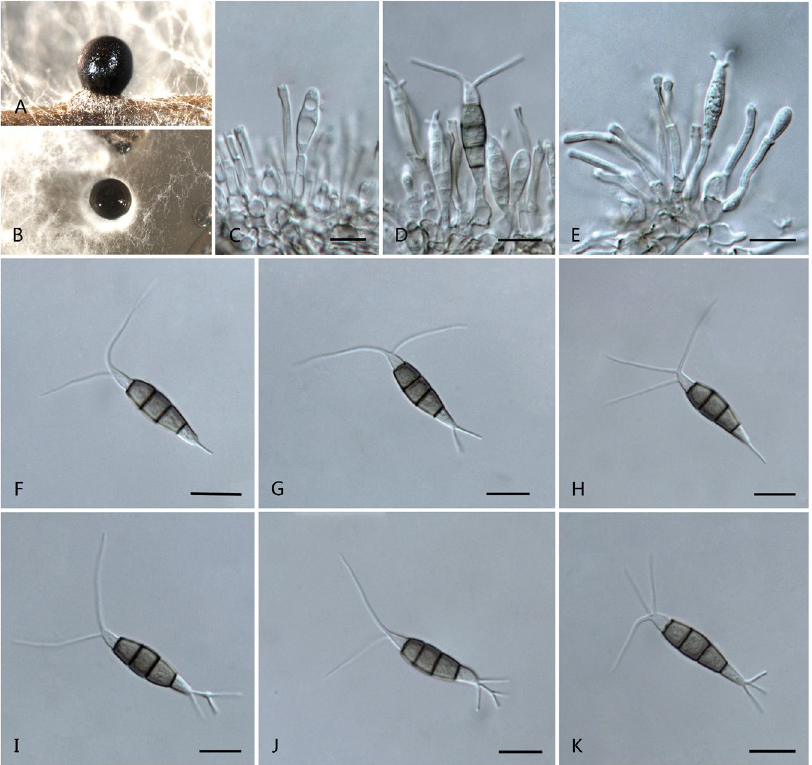
Figure 7. Pestalotiopsis brachiata (from ex-holotype culture CGMCC 3.18151 ( = LC2988)). ( A ) Conidioma sporulating on pine needle. ( B ) Conidioma sporulating on PDA. ( C–E ) Conidiogenous cells and conidia. ( F–K ) Conidia. Scale bars = 10 μ